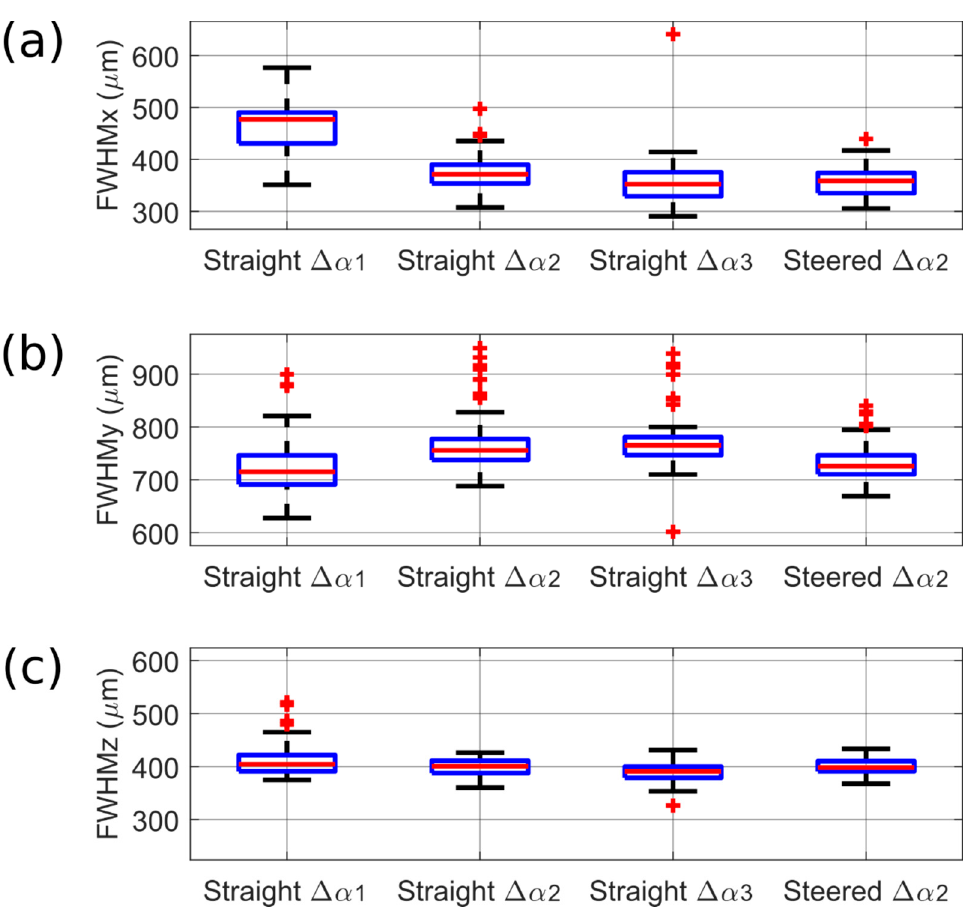
Figure 6. Boxplots of the FWHM along the three axes of the coordinate system: ( a ) FWHM along the x-axis, FWHMx, ( b ) FWHM along the y-axis, FWHMy, ( c ) FWHM along the z-axis, FWHMz. The median value is shown with the red line. The box indicates the IQR values and the outliers are shown with red crosses. In abscissa, the scanning name corresponds to the type of transmit and the angular period. The angular periods are Δ α 1 ≈ 8°, Δ α 2 ≈ 4°, and Δ α 3 ≈ 2°.